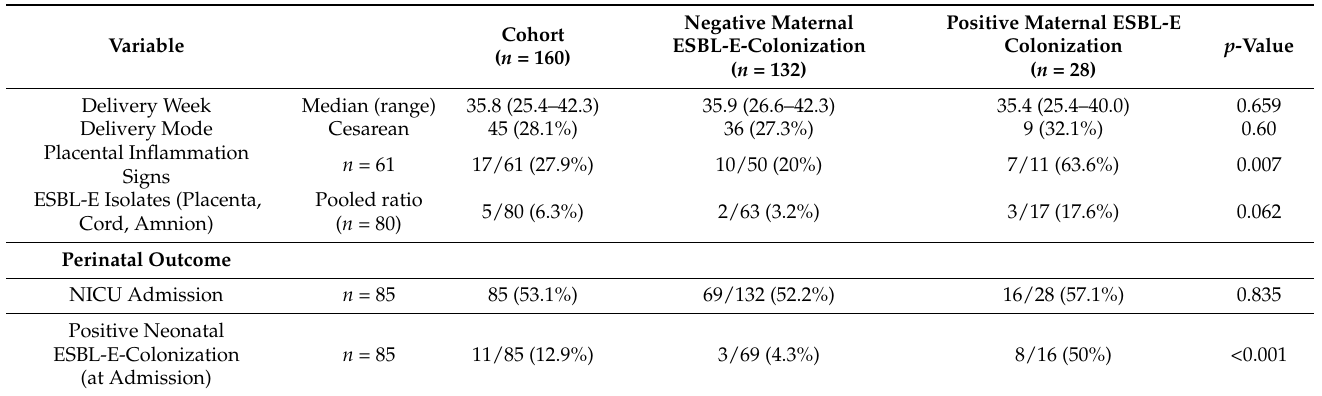
Table 4. Association between maternal ESBL-E colonization and perinatal